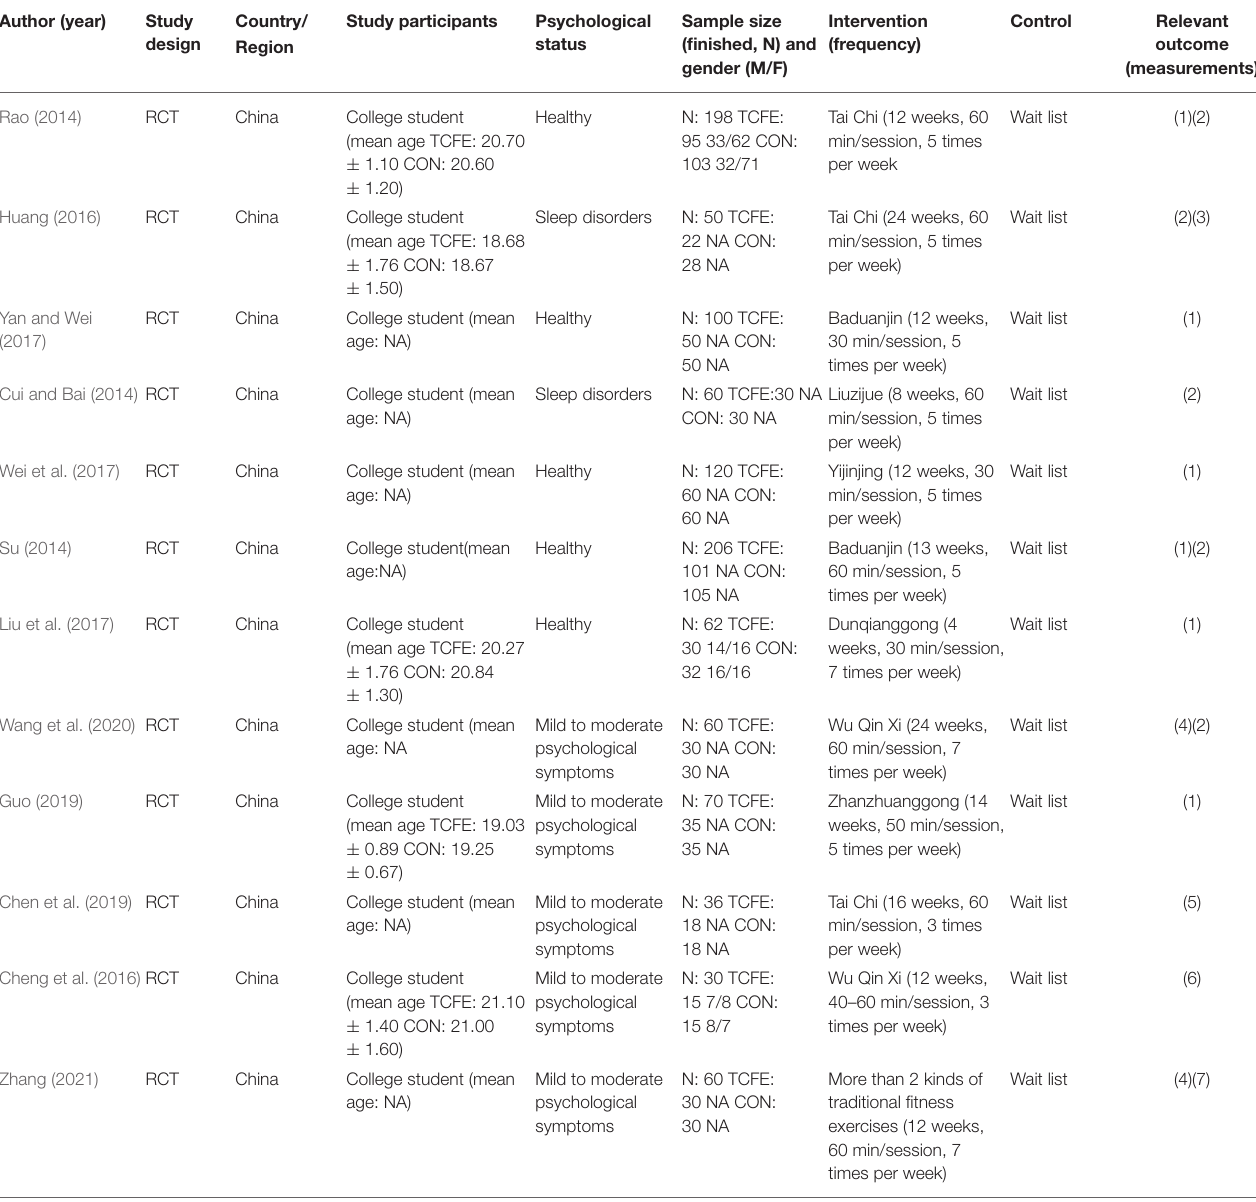
TABLE 1 | Characteristics of included study ( n =